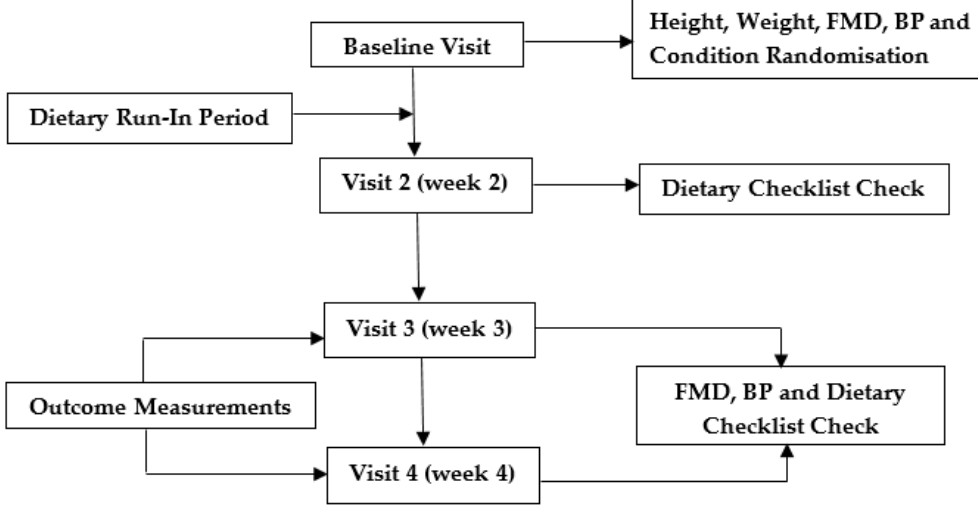
Figure 2. Schematic overview of study. Abbreviations: FMD: Flow mediated dilatation; BP: blood pressure.